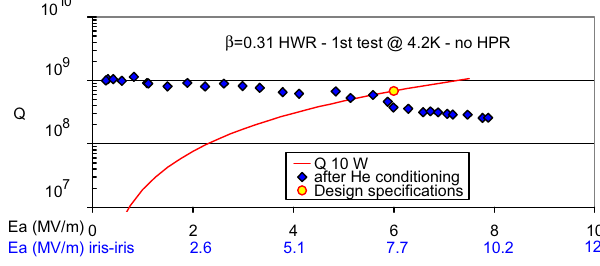
FIG. 8. (Color) Medium- (cid:1) HWR performance at 4.2 K. Active length 224 mm (175 mm with the Spoke definition, correspond- ). ing to the gradient E a iris - iris